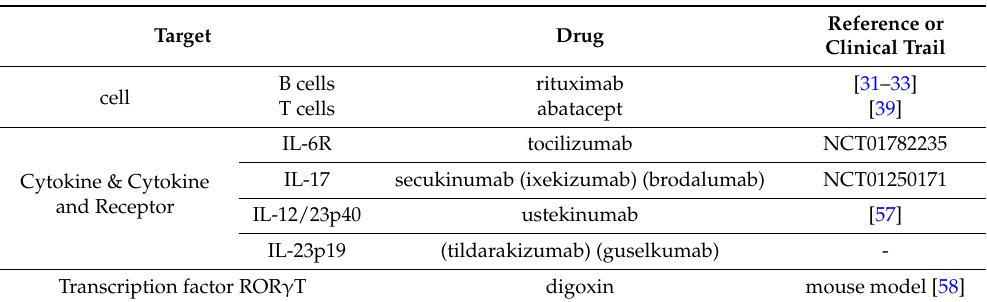
Table 1. Therapeutic tools against primary Sjögren’s syndrome. Listed are therapeutics that target Th17 cytokines, cytokine receptors and transcription factors and thus may correct the Th17/Treg imbalance associated with the